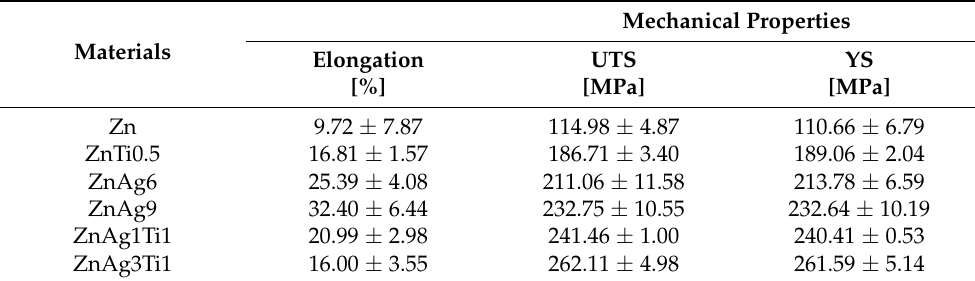
Table 2. Mechanical properties of zinc and zinc alloys during tensile testing according to DIN ISO